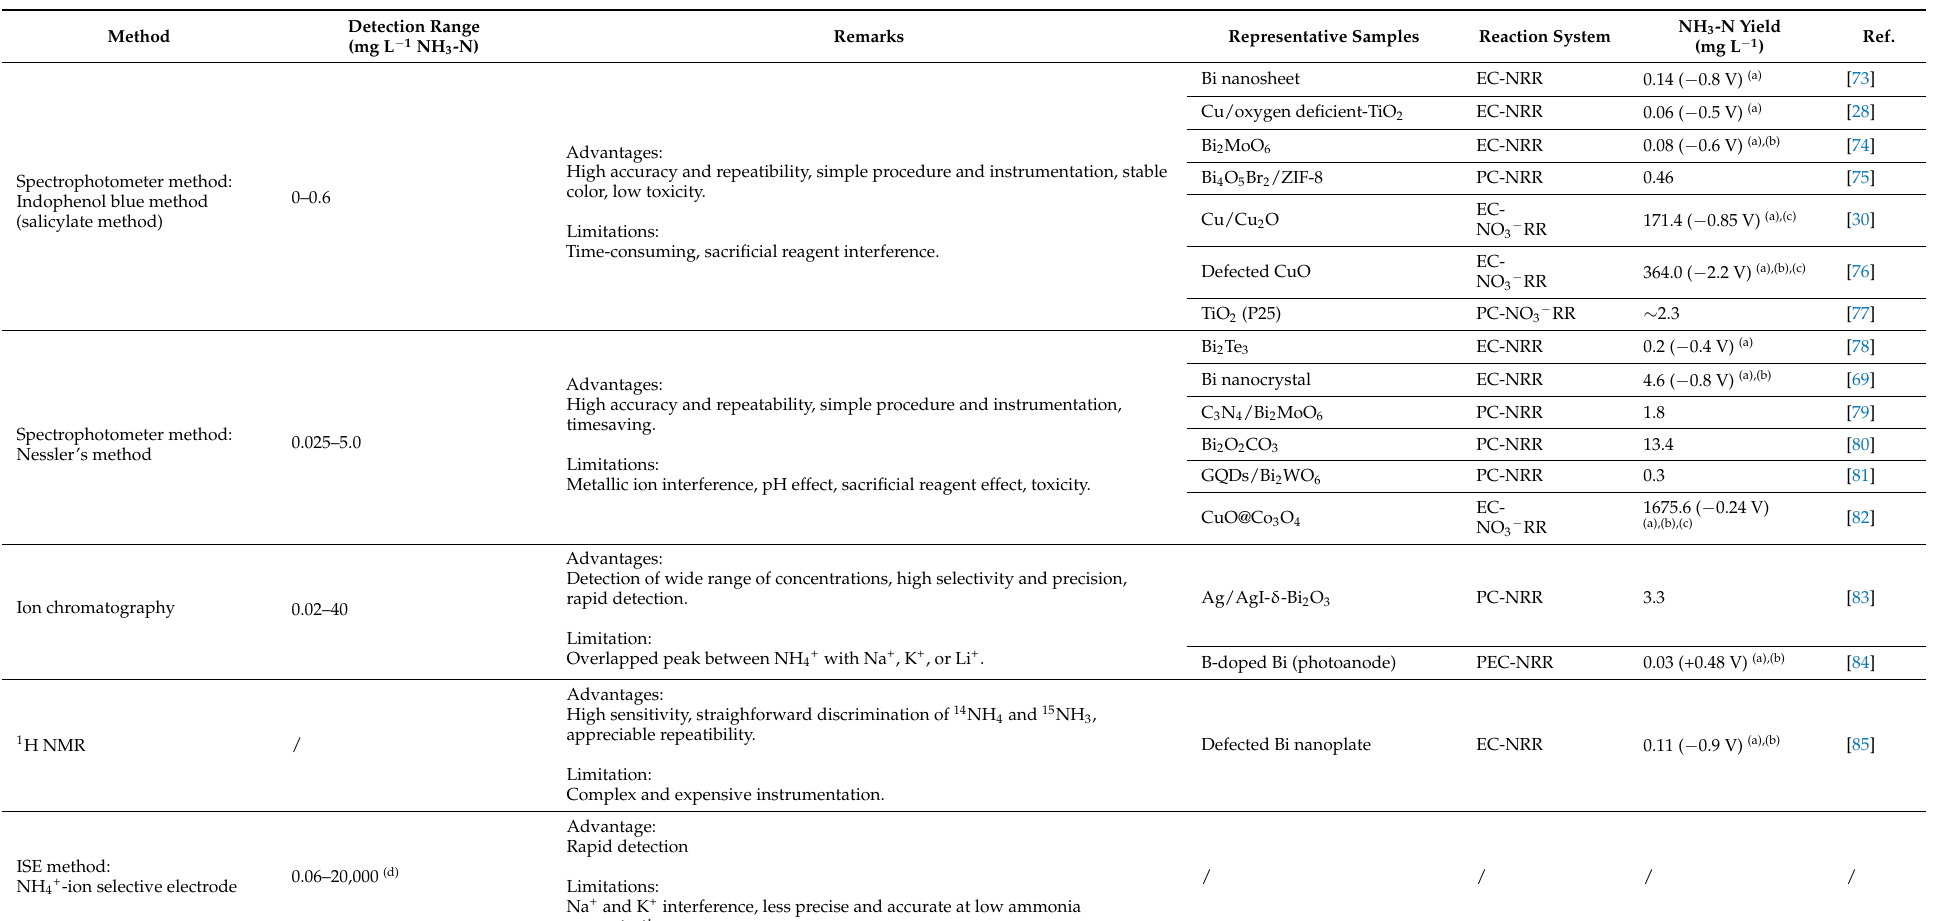
Table 1. Comparison of the ammonia quantification methods with some representative